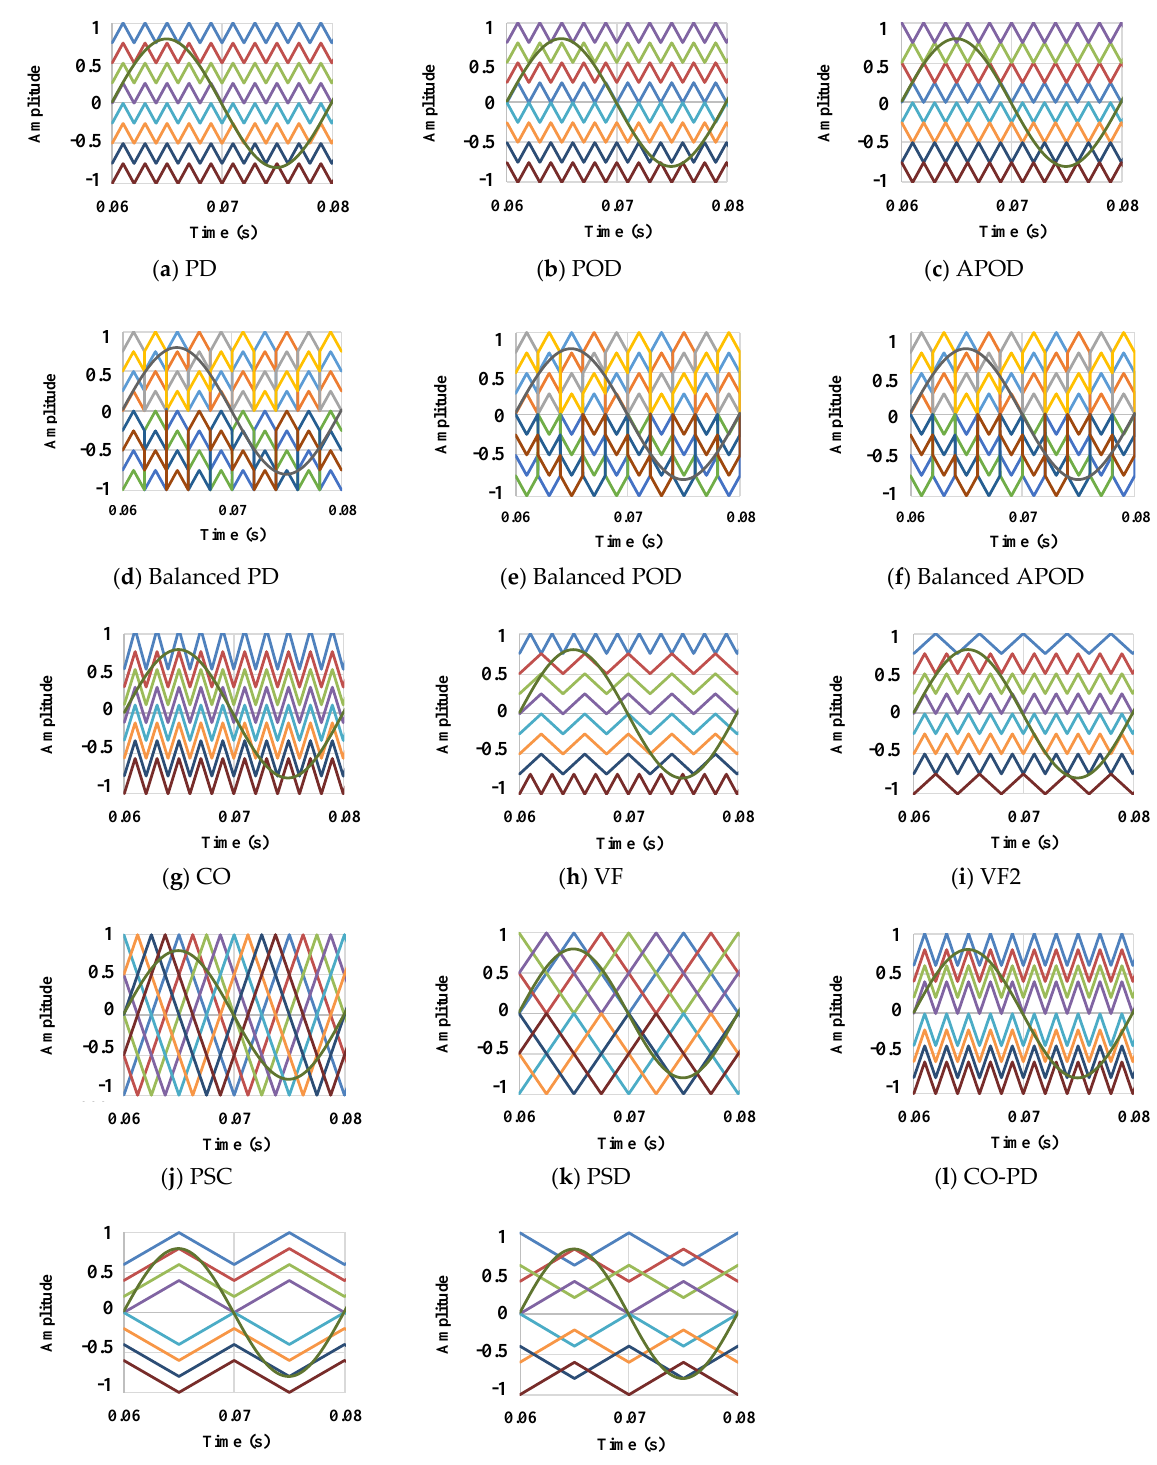
Figure 11. Illustration of the carrier and modulation wave forms for different PWM techniques: ( a ) PD, ( b ) POD, ( c ) APOD, ( d ) Balanced PD, ( e ) Balanced POD, ( f ) Balanced APOD, ( g ) CO, ( h ) VF ( i )